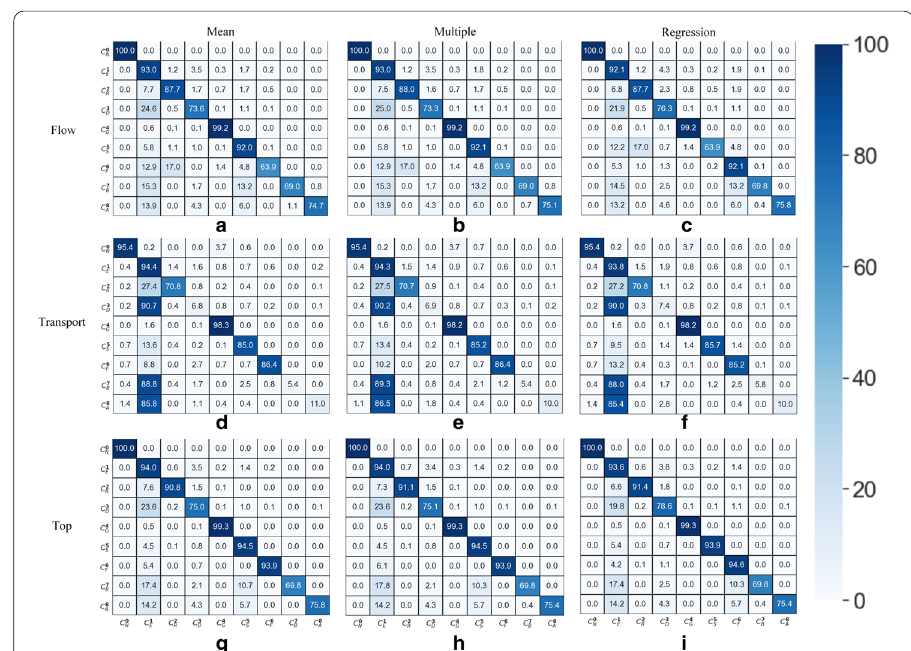
Fig. 9 Multi-class Classification Confusion Matrices on Feature Clusters Data-set using RF. a – c are of flow features using mean, multiple and regression imputation, d – f are of TCP features using mean, multiple and regression imputation and g – i are of top features from flow and TCP using mean, multiple and regression